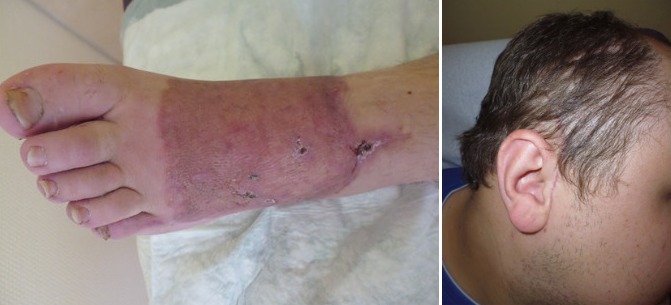
Nine weeks post-op